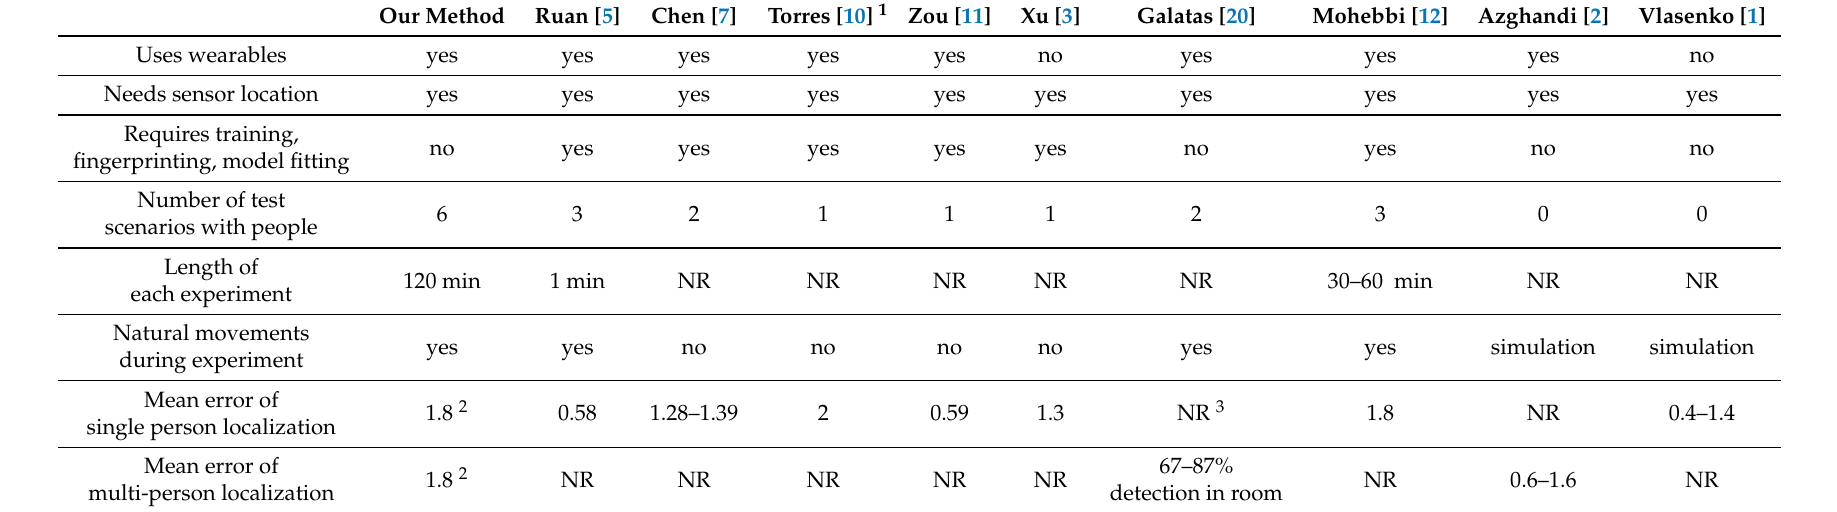
Table 7. Comparing indoor localization